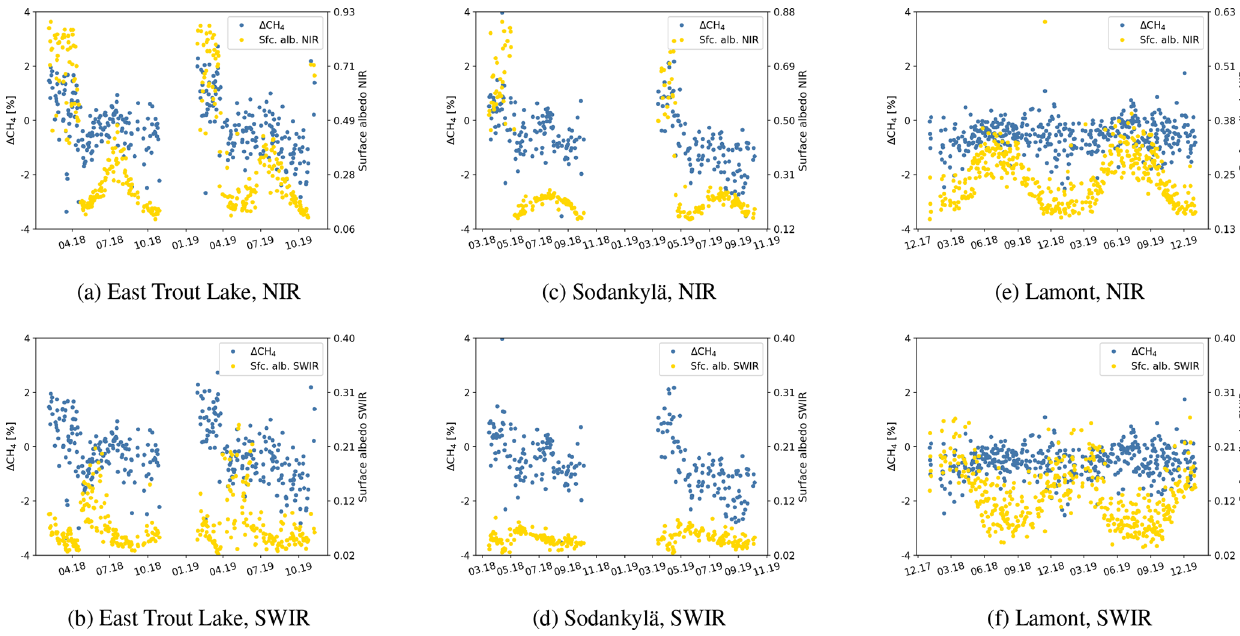
Figure 9. Daily mean relative differences (blue, left axis) between TROPOMI and TCCON XCH 4 ( (cid:49) CH 4 ) and surface albedo in the NIR (yellow, secondary axis, a, c, e ) and surface albedo in the SWIR (yellow, secondary axis, b, d, f ) at East Trout Lake (54.3 ◦ N) (a, b) , Sodankylä (67.4 ◦ N) (c, d) and Lamont (36.6 ◦ N) (e, f)